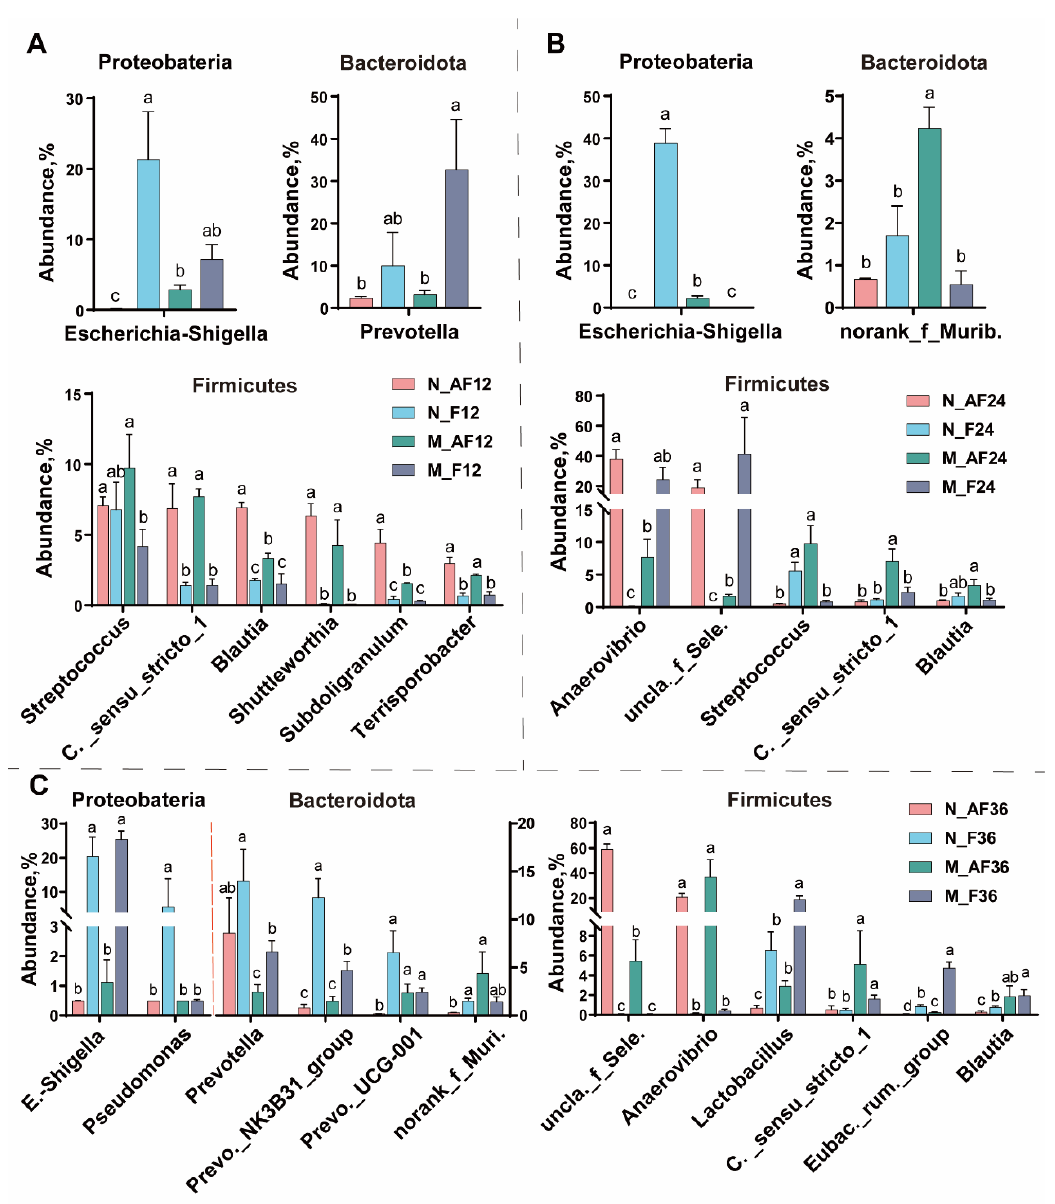
Figure 8. Several differential genera exhibiting the first 15 bacteria among different treatments at 12 h ( A ), 24 h ( B ) and 36 h ( C ) during fermentation. Statistical significance was determined by Kruskal–Wallis test.